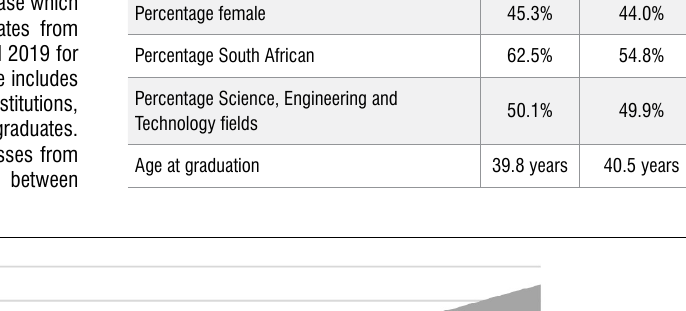
Measures of representativeness of survey sample Variable